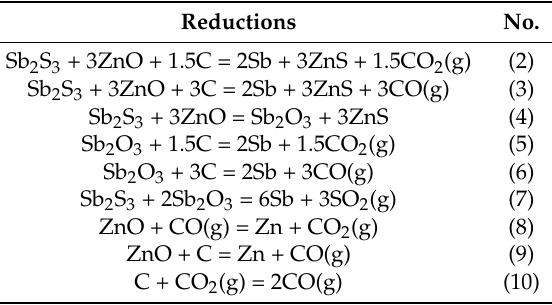
Table 1. Reactions possible during the experiment.